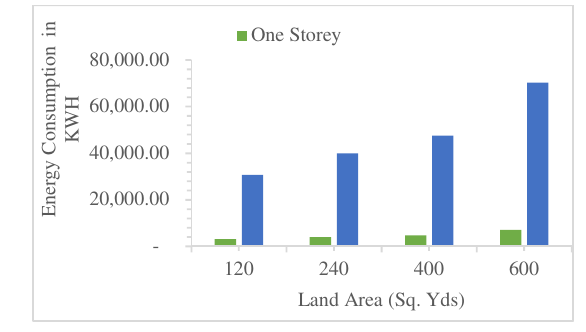
Fig. 5: Average Annual Energy Consumption of Residential Buildings (Source: K.E ) High-rise buildings are mostly being built along the main roads in the areas having the high commercial values including Gulistan-e-Johar, Gulshan-e-Iqbal,